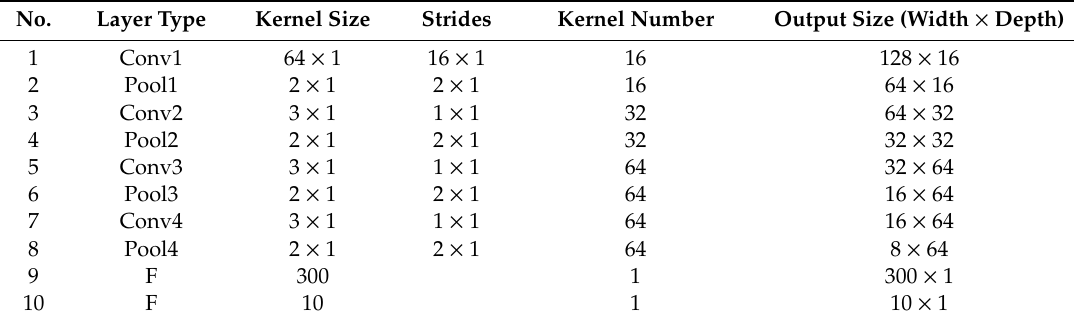
Table 1. Parameters of 1DCNN algorithm applied in the experiments.